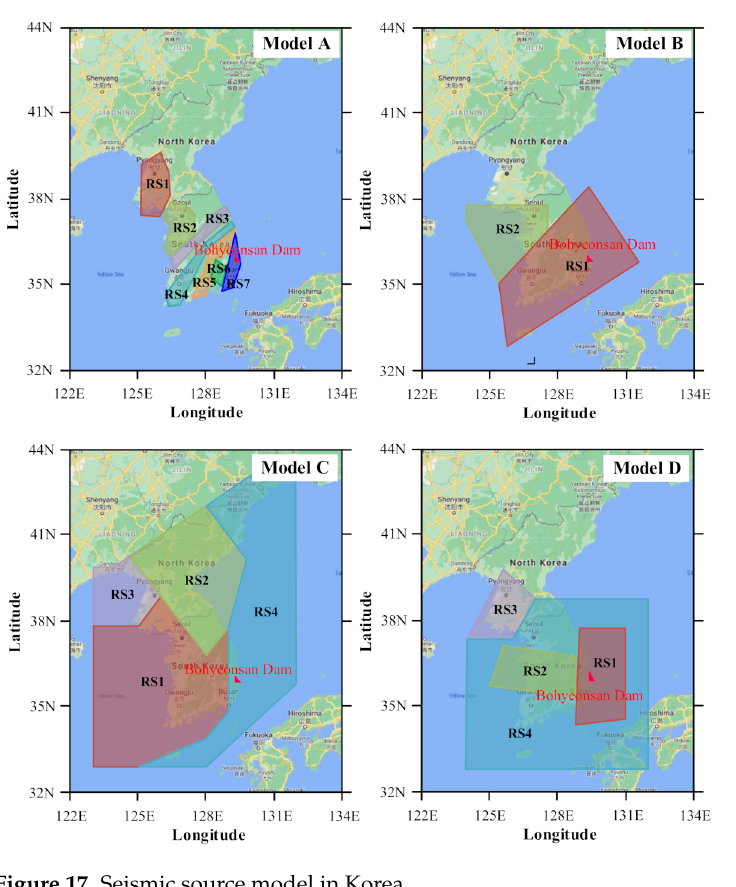
Figure 17. Seismic source model in Korea.